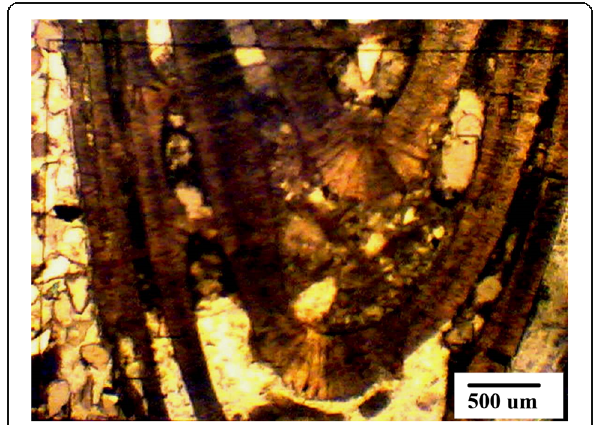
Fig. 7 Nummulitic rudstone microfacies showing Nummulite gizehensis embedded in sparry calcite matrix,